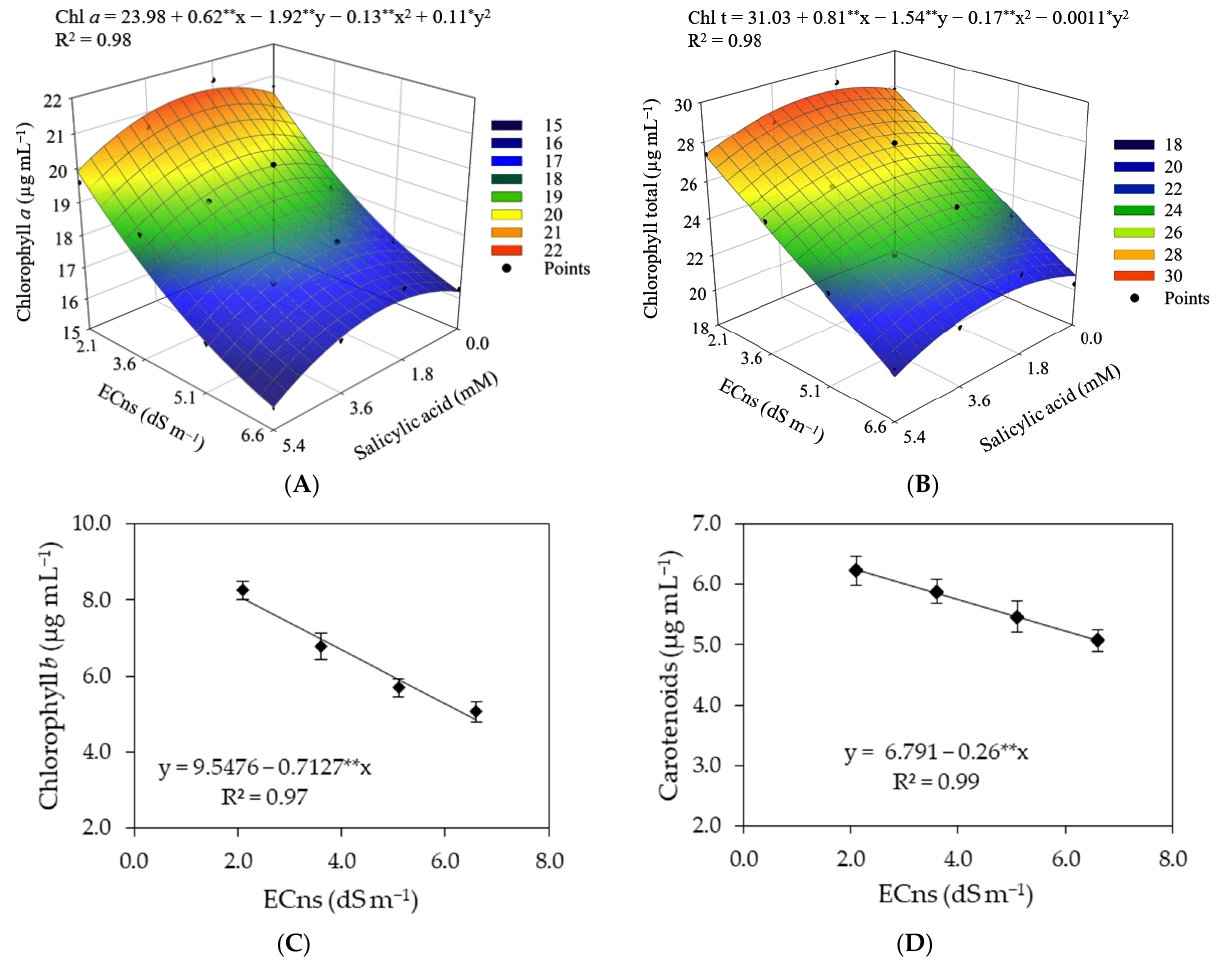
Figure 6. Response surface for chlorophyll a —Chl a ( A ), chlorophyll total— Chl total ( B ), chlorophyll b —Chl b ( C ), and carotenoids—Car ( D ) of Japanese cucumber as a function of the interaction between the electrical conductivity of the nutrient solution (ECns) and the concentrations of salicylic acid (SA), grown in a hydroponic system, 40 days after transplanting. X and Y—concentration of SA and ECns, respectively; * and ** significant at a p ≤ 0.05 and p ≤ 0.01, respectively. Vertical lines represent the standard error of the mean ( n = 4).